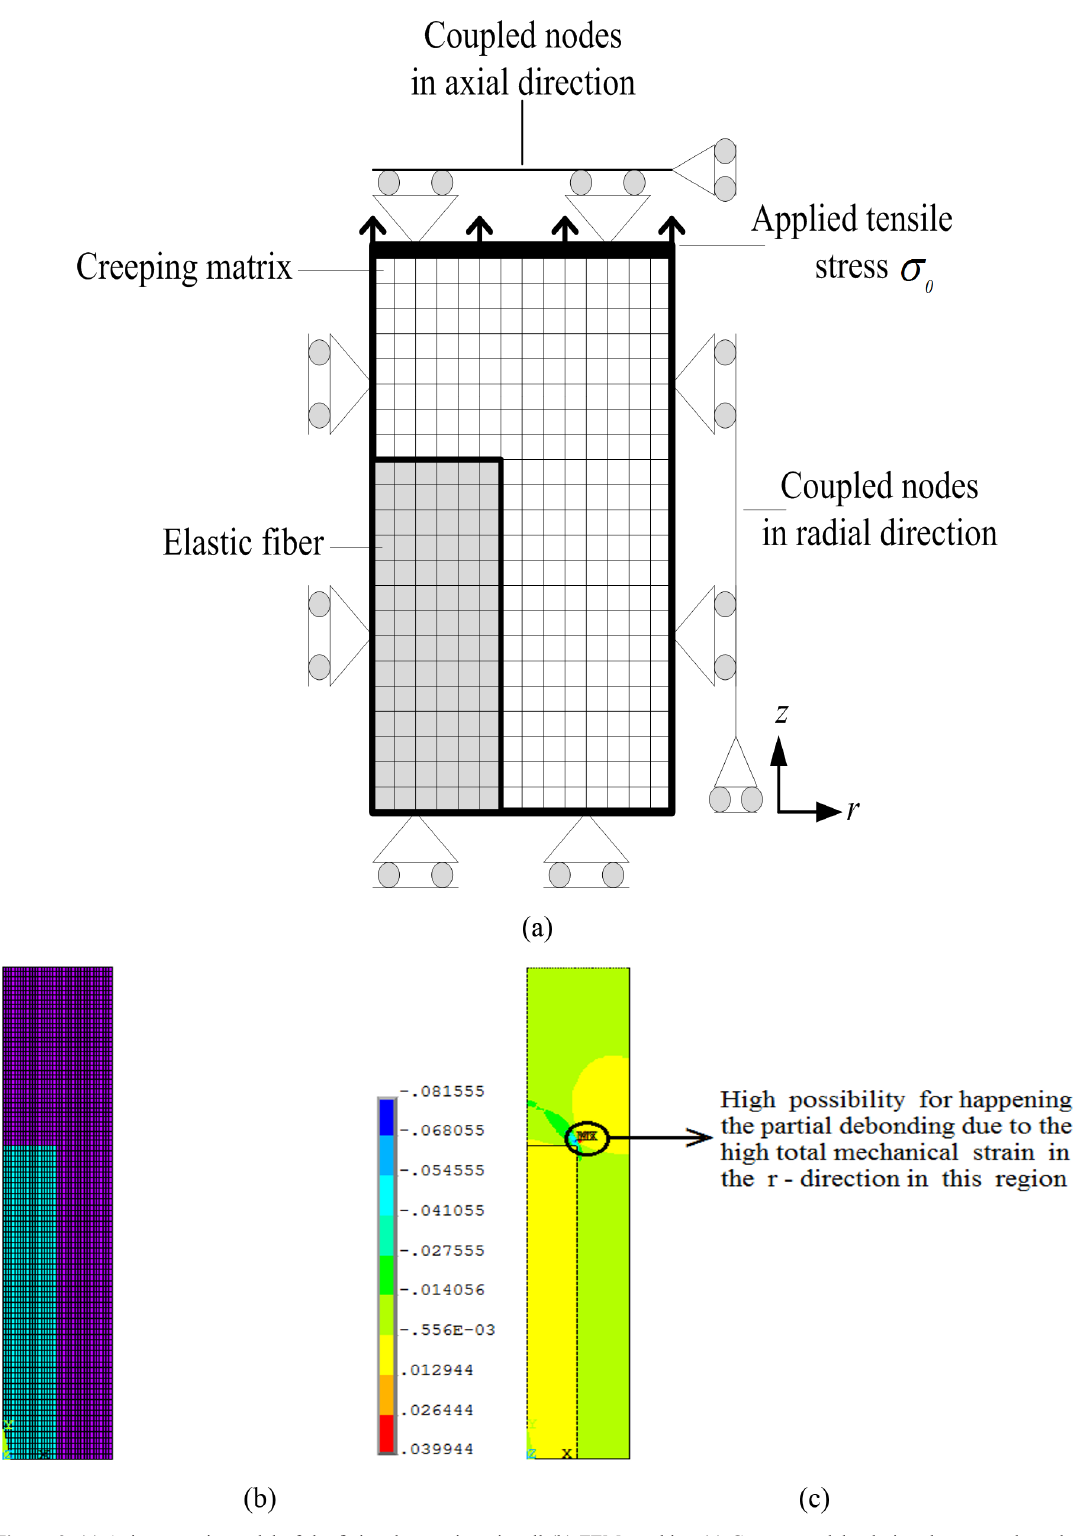
Figure 3. (a) Axisymmetric model of the finite element in unit cell (b) FEM meshing (c) Contour nodal solution data to analyze the r-component of total mechanical strain [x = r (radial), y = z (axial), z = θ